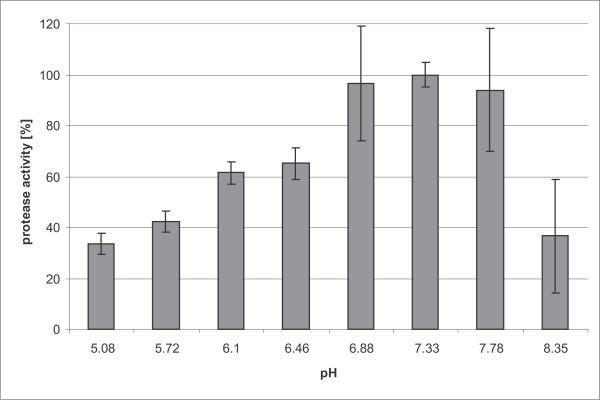
pH dependency of protease activities. The pH profile of protease activity in T. thermophila supernatants is shown. The overall activity has its maximum at neutral to slightly basic pH. Error bars represent standard errors of three independent experiments.